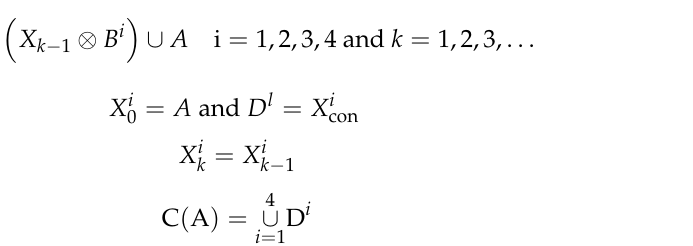
Figure 6. Color segmentation result. ( a ) Color image-( b ) Masked color pads’ image. Each image convex hull is then extracted from each frame, and the best convex hull is cited as the smallest convex set that contains all the region’s pixels in the Euclidean plane [38–40].